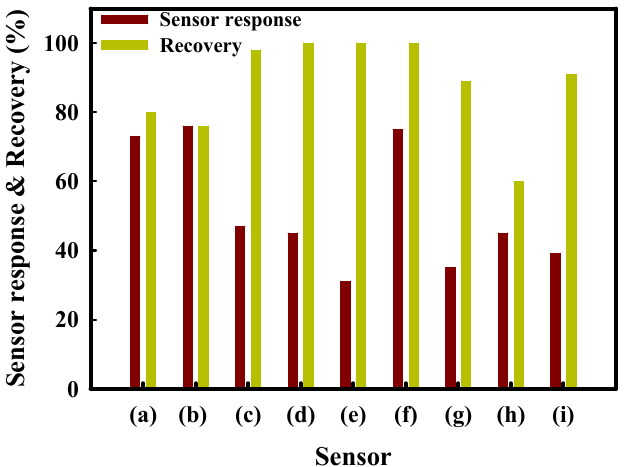
Figure 5. Responses and recoveries of the SnO amounts of metal oxides at a H (b) Sn(12)Mo1; (c) Sn(12)Mo3; (d) Sn(12)Mo5; (e) Sn(12)Mo5Ni1; (f) Sn(12)Mo5Ni3;